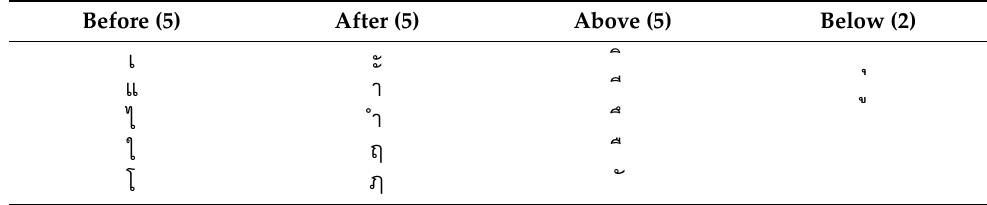
Table 1. The 17 Thai vowel forms based on Thai